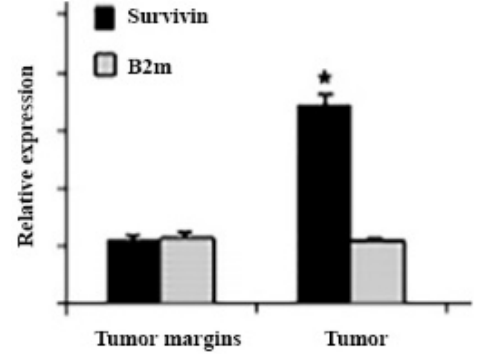
Fig. 2. Real-time PCR for RNA s extracted from FFPE samples. * shows the significant differential expression of the survivin in osteosarcoma compared to the margins ( p ≤